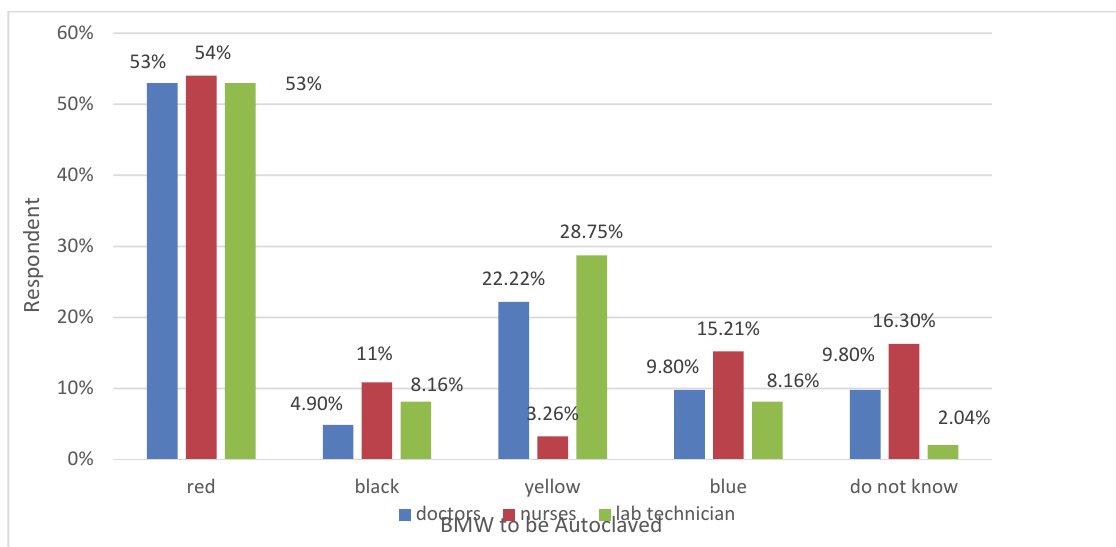
Fig. 12. Color code of biomedical waste to Autoclaved, Disinfected